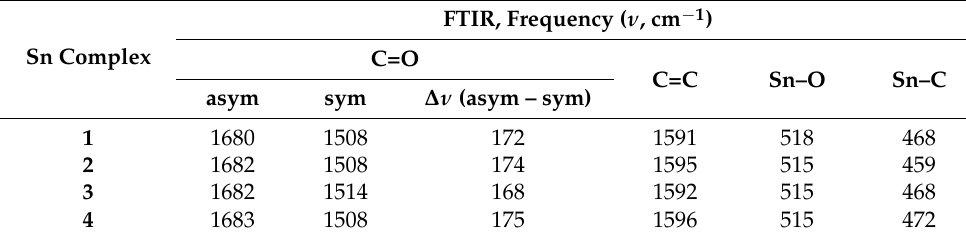
Table 2. Fourier transform infrared FTIR spectral data of complexes 1 – 4